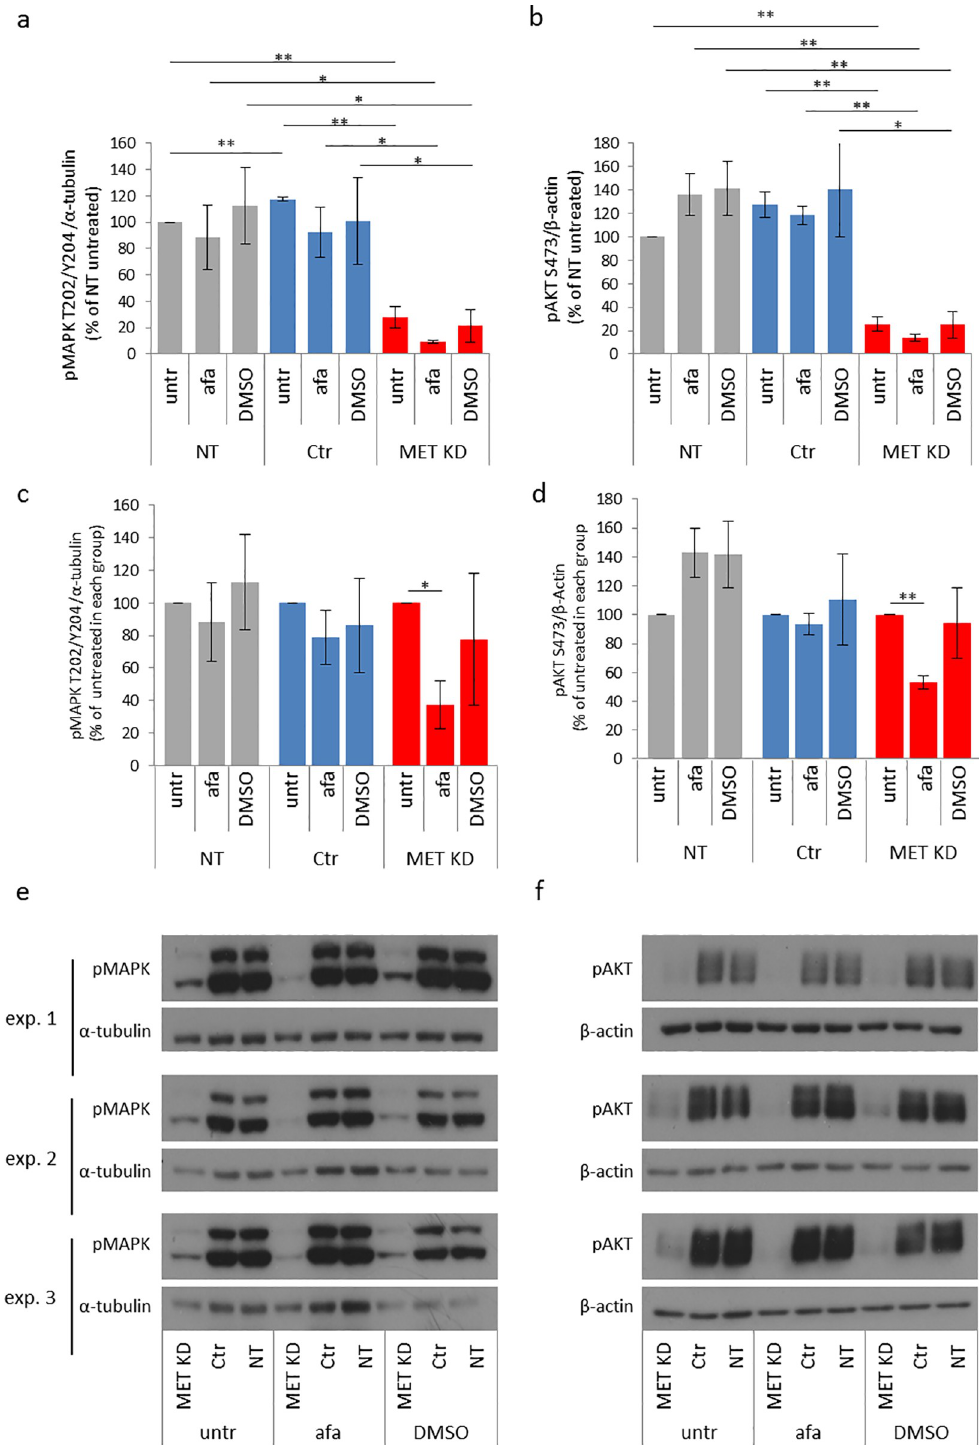
Fig 4. Afatinib decreases MAPK and AKT activation after MET knockdown. Hs746T cells were transfected with MET siRNA (MET KD) or control siRNA (Ctr). Non-transfected cells (NT) were analyzed in parallel. Two days after transfection, cells were treated with 0.5 μ M afatinib or 0.05% DMSO (solvent control) for 20 minutes. Cell lysates were analyzed by Western blot with antibodies against pMAPK T202/Y204 (a,c) and pAKT S473 (b, d). Data are shown as percent of NT untreated cells (a, b) or as percent of untreated cells of each group (NT, Ctr, MET KD) (c, d). The mean of